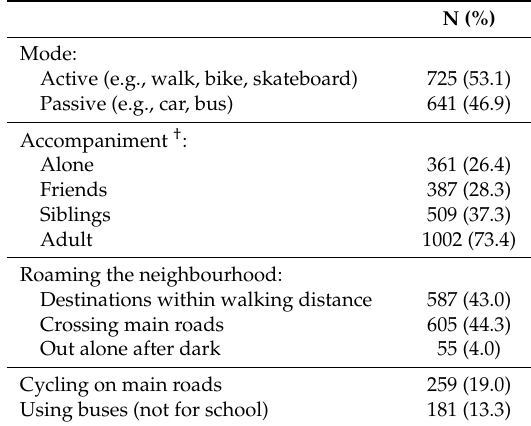
Table 4. Children’s travel to school and independent mobility (N = 1366).